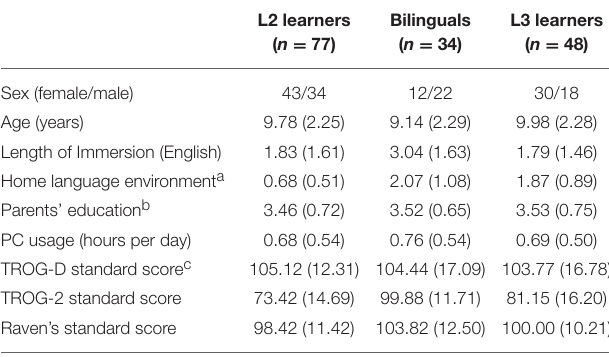
TABLE 1 | Mean scores (and standard deviations) for background measures by language